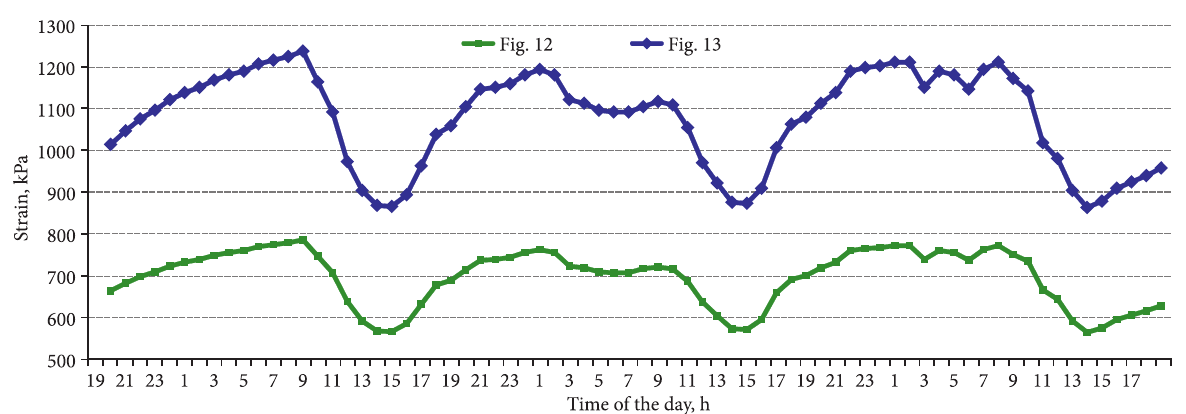
Fig. 21. Mode of deformation for the upper asphalt concrete layer presents stresses during the days with max negative temperatures (schemes in Figs 12 and